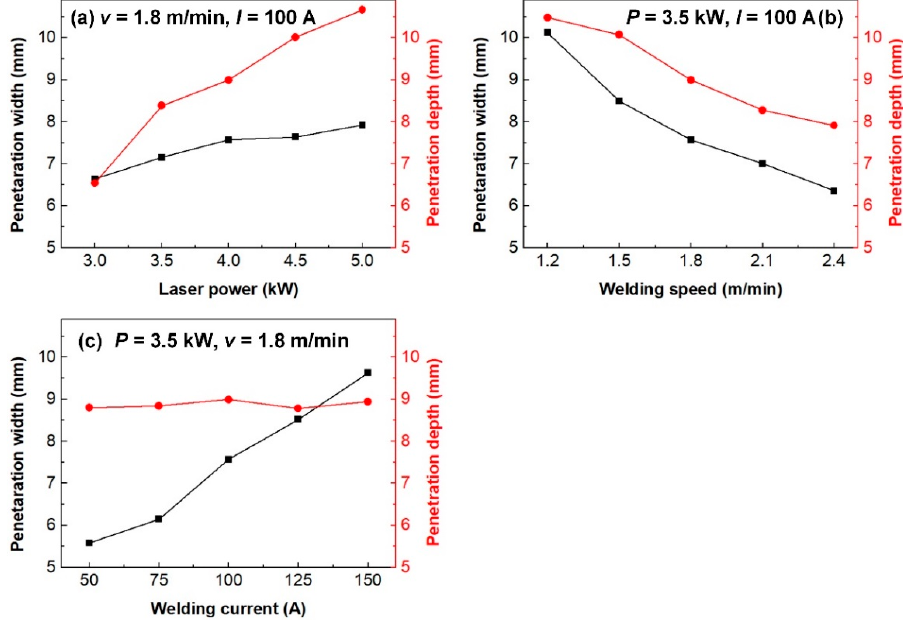
Figure 7. Relationship between processing parameters and penetration depth/width; ( a ) laser power, ( b ) welding speed and ( c ) welding current.